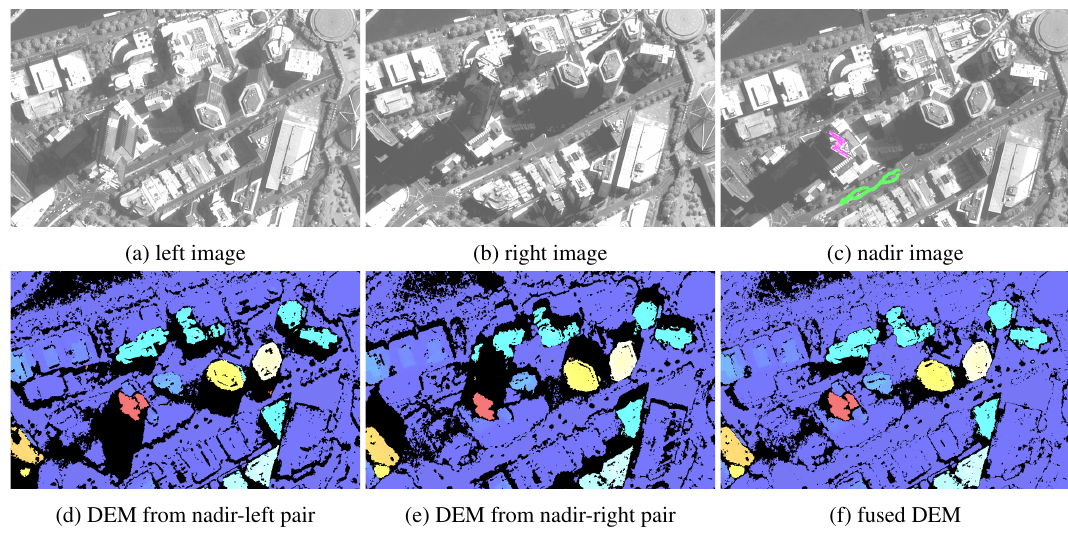
Figure 12: Three Pléiades images of Melbourne (a-c), the roof and street areas used for the evaluation are highlighted in (c). The elevation maps obtained by taking only two images are shown in (d) and (e), while (f) corresponds to the fusion with outlier filtering. Black areas represent rejected pixels.